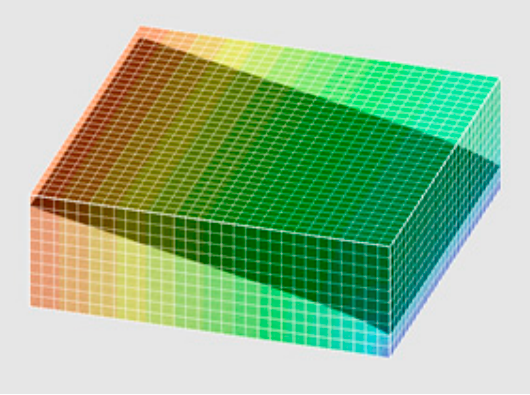
Figure 4. Pressure head cloud diagram for a single-sided infiltration model of drainage asphalt material rutted slabs.